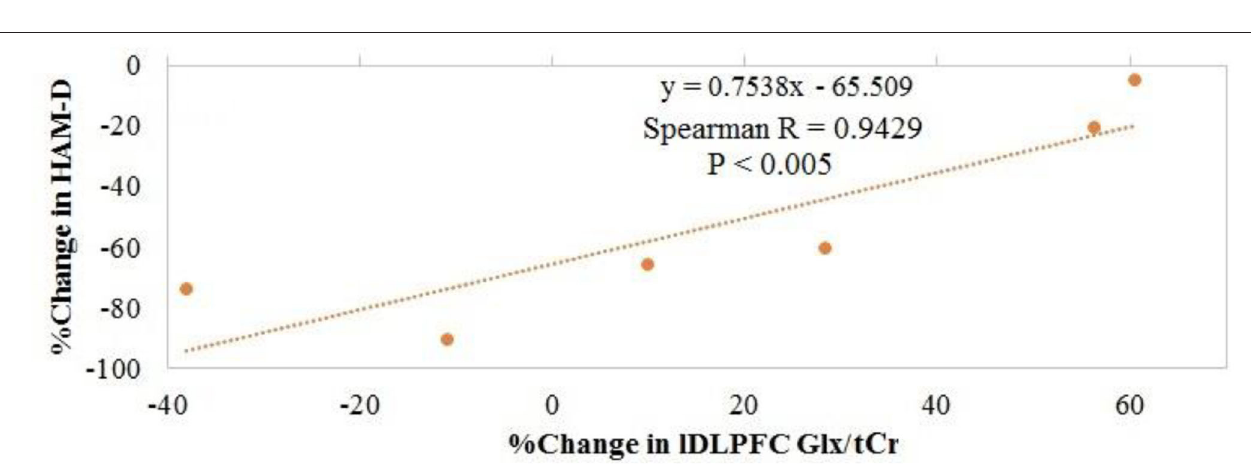
of detecting GABA association. Signal to noise ratio and fitting error can be improved with GABA + acquisition (103), but our choice of macromolecule-minimized GABA accounts for any inter-subject macromolecule level differences